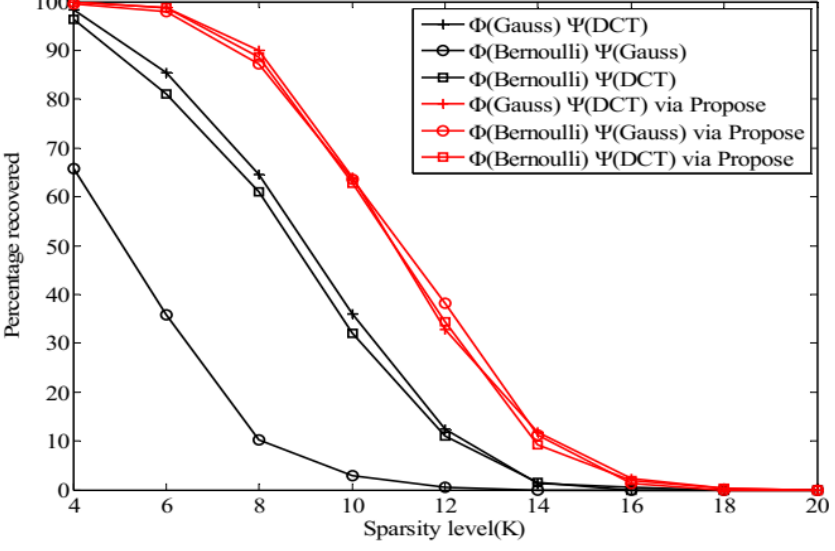
Figure 9. The change tendency of P suc with K while M = 28 in the noiseless